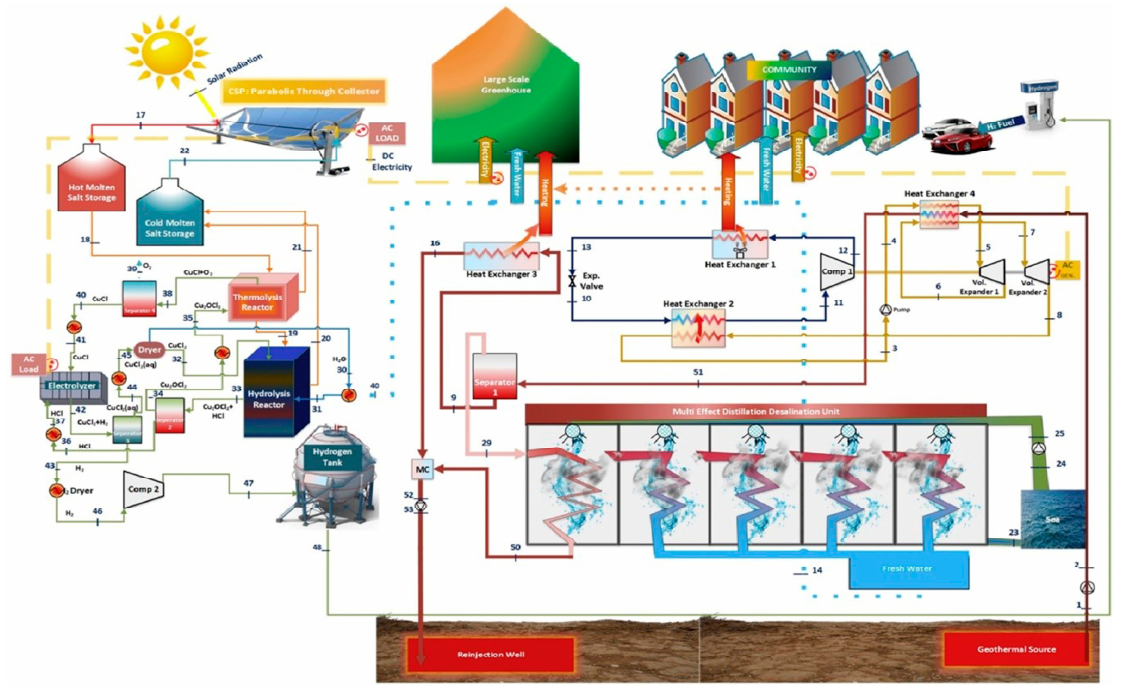
Figure 11. Schematic of hybrid system [120], reused with permission from Elsevier (license number 5491441455072).